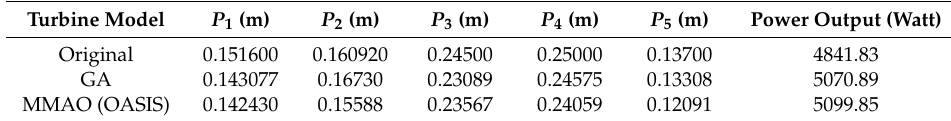
Table 4. Parameter values from the optimization results and steady analyses’ results.